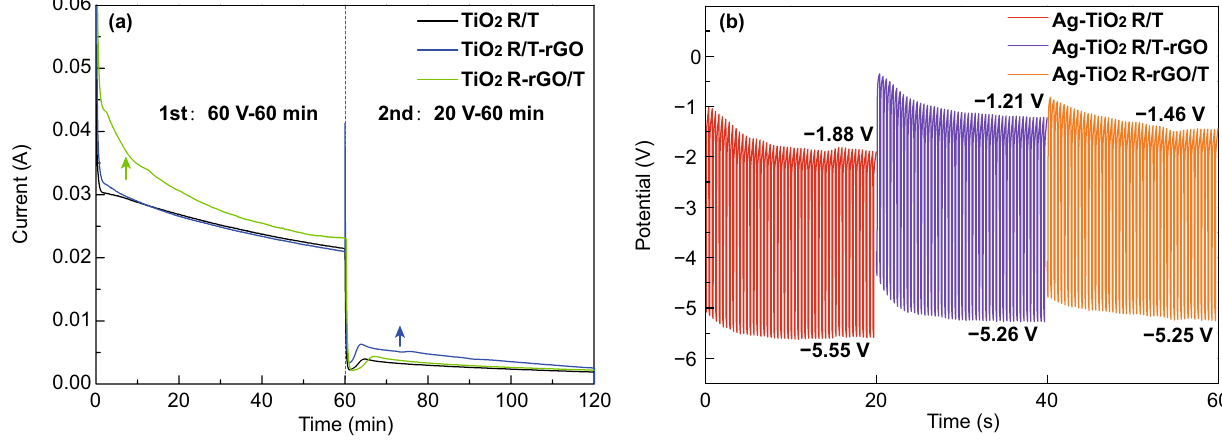
Fig. 3 a The I-t curves in the two-step anodic oxidation process and b U-t curves in pulse electrodeposition of TiO 2 hierarchical